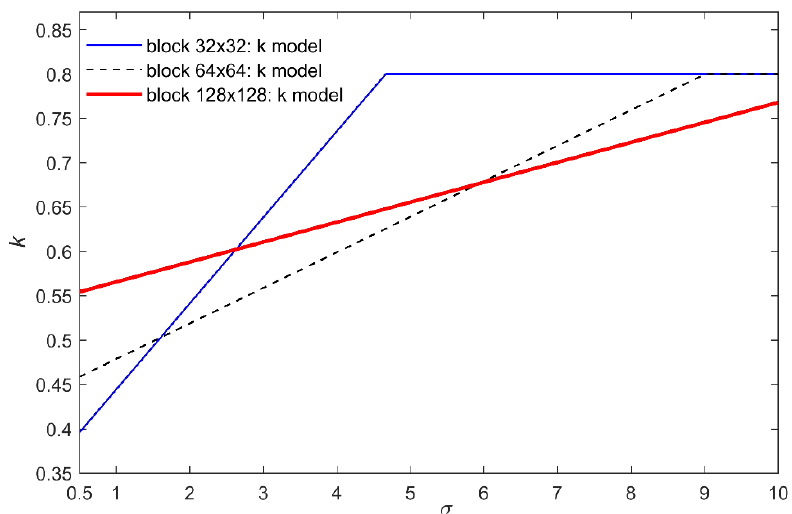
Figure 5. The proposed functions for adjusting the singular value tail length according to the initial noise level estimates for three different choices of block size.